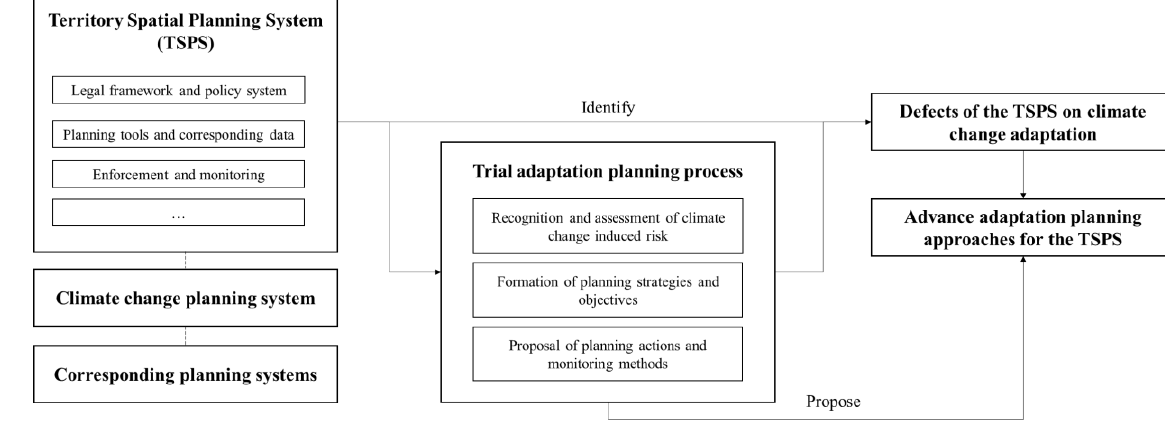
Figure 7. Methodology framework.